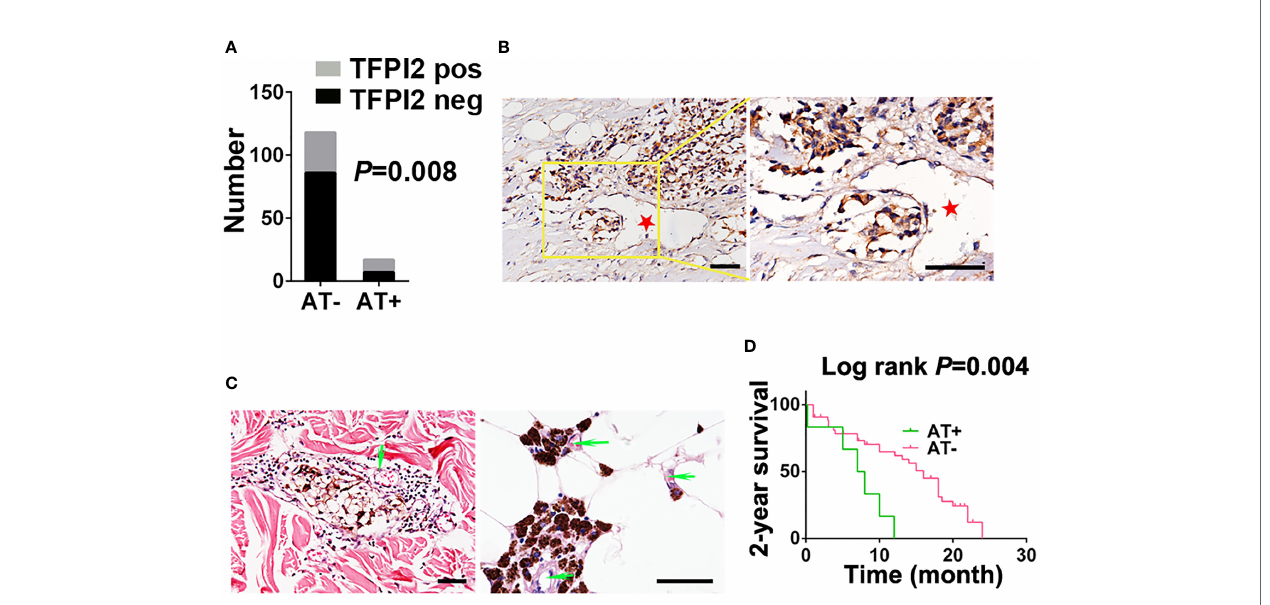
FIGURE 7 | Correlation between TFPI2 expression and angiotropism and prognostic signi fi cance of angiotropism in melanoma patients. (A) The histogram shows the proportions of TFPI2-positive staining in the angiotropism-present (AT+) and angiotropism-absent (AT − ) groups of the TMU-CM cohort. (B) Representative IHC staining images for TFPI2 show that melanoma cells cuf fi ng the external surfaces of blood vessels (stars) were TFPI2-positive. Scale bar 50 m m. (C) Representative HE images show that pigmented melanoma cells were closely apposed to the external surface of blood vessels (arrows) in the dermis (left) and adipose tissue (right). (D) Kaplan – Meier estimates of 2-year survival for TMU-CM cohort patients who were strati fi ed into two groups: angiotropism-present and